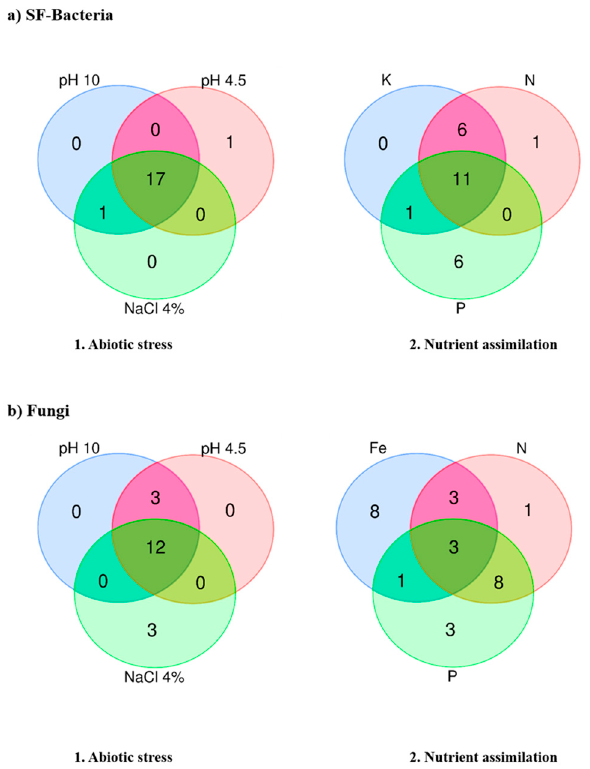
Figure 3. Venn diagram analysis based on abiotic stress tolerance and limited nutrients in media. ( a ) SF-bacteria isolates results based on the survival number. ( b ) Fungi isolates results based on the survival numb.